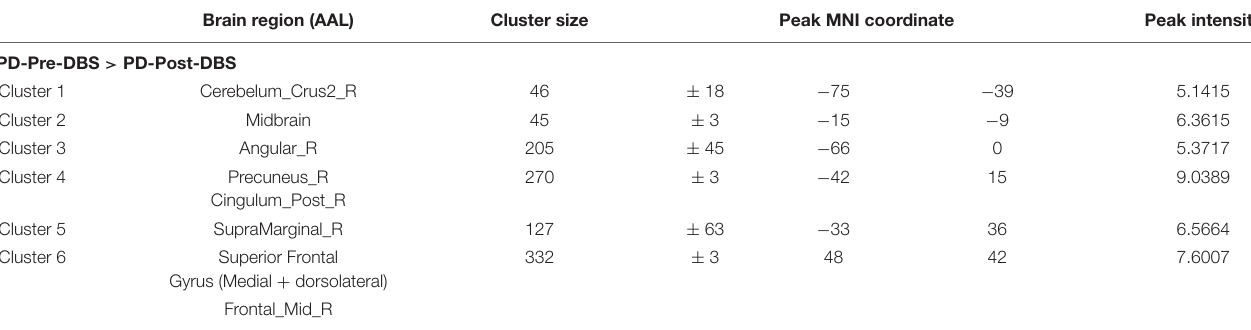
TABLE 2 | VMHC differences between the PD-Pre-DBS and PD-Post-DBS group. Brain region (AAL) Cluster size Peak MNI coordinate Peak